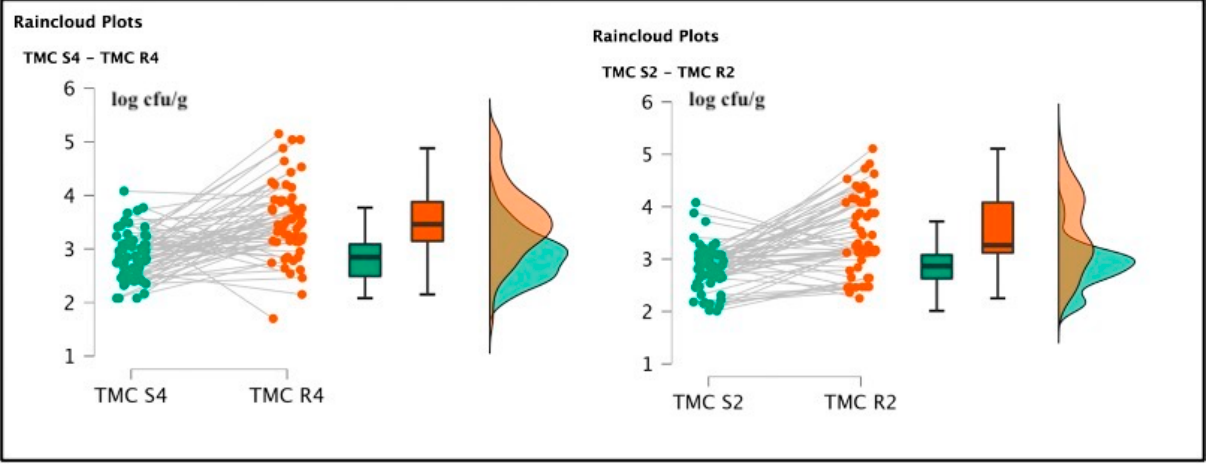
Figure 3. Raincloud plots representing TMC value distributions from differently salted to rehydrated products. For each graphic, the vertical axes report the calculated bacterial loads, and the horizontal axes indicate the screened TMC values from S4–R4 (on the left) and S2–R2 (on the right) analyzed food matrices.